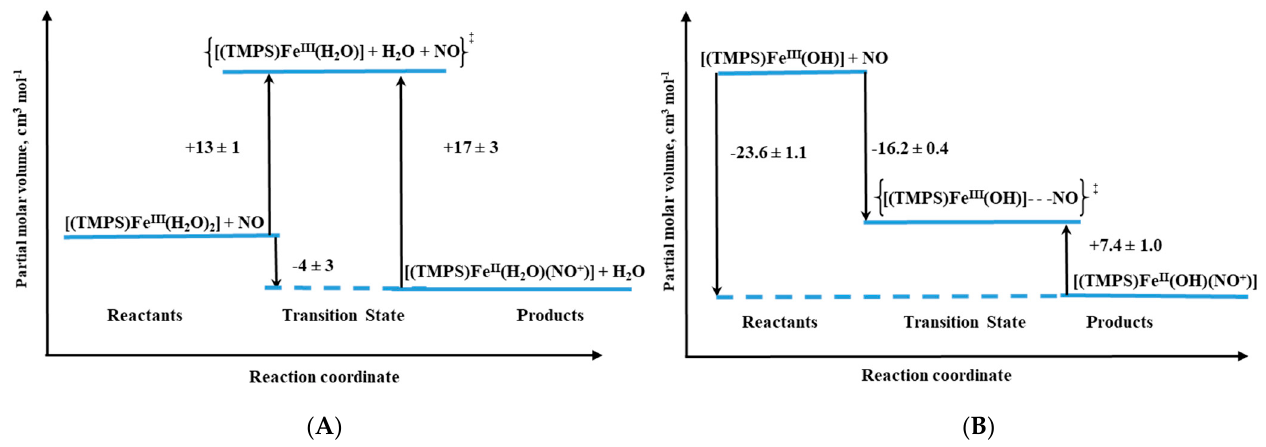
Figure 10. Volume profiles for reversible NO binding to Fe(TMPS) ( A ) (TMPS)Fe III (H 2 O) 2 and ( B ) (TMPS)Fe III (OH) under acidic and alkaline conditions, respectively.